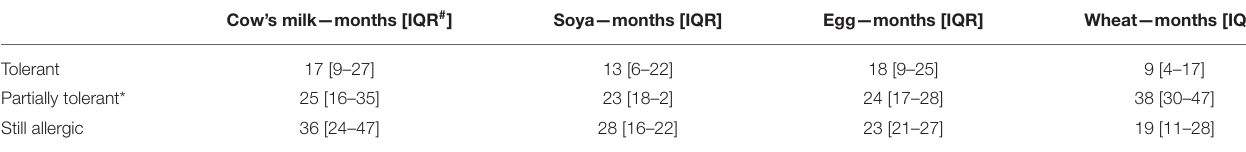
TABLE 2 | Mean age when children had the HIP and outcome categorized by tolerant, partially tolerant and still